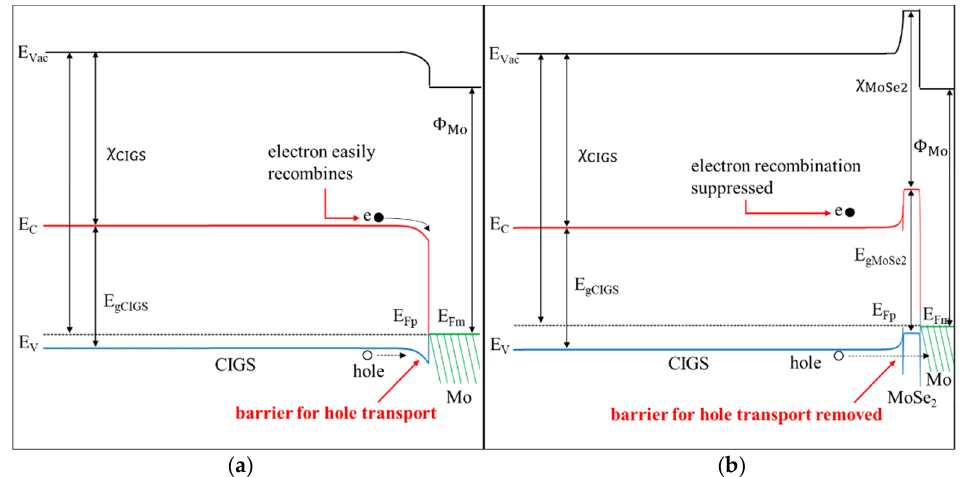
Figure 3. Schematic energy band diagram of ( a ) CIGS/Mo after contact; ( b ) CIGS/MoSe 2 /Mo after contact.